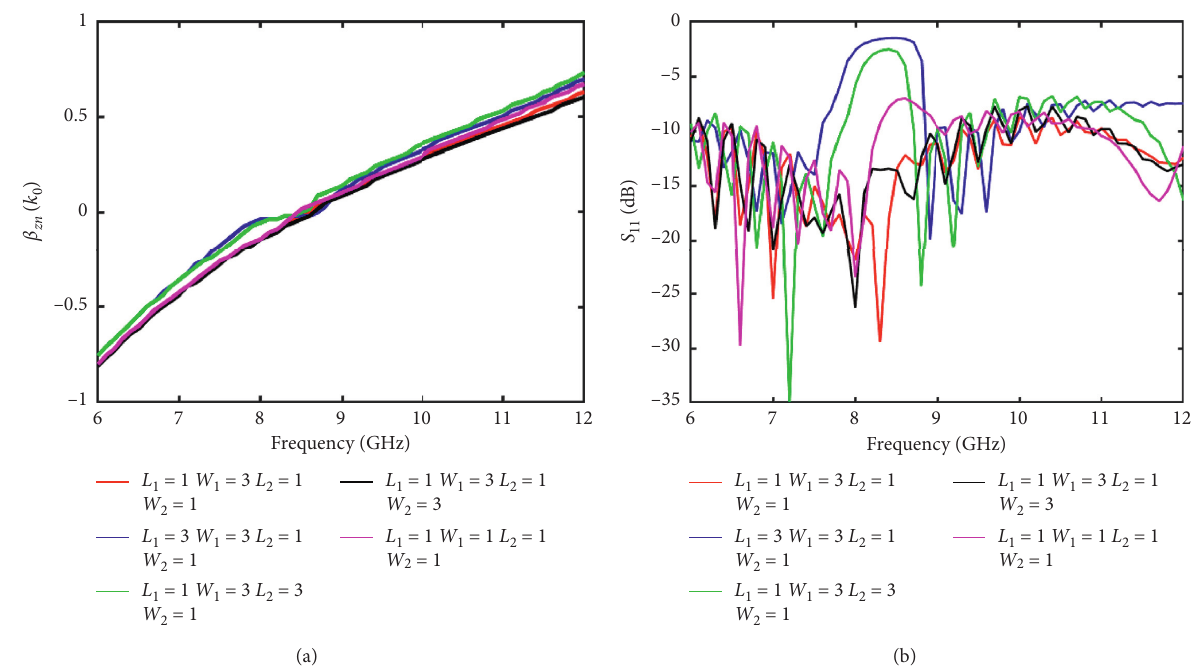
Figure 13: The simulated normalized phase constants and S -parameters of the proposed periodic antenna with different slot parameters.